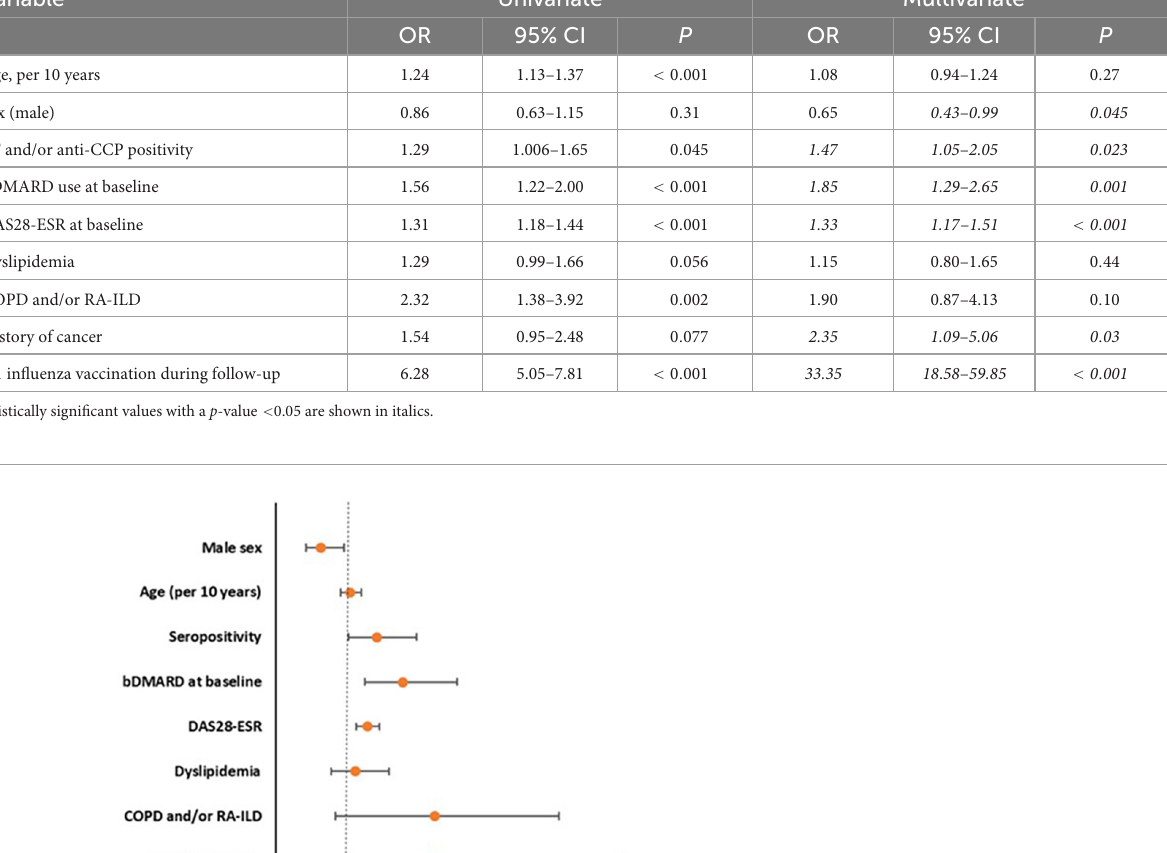
TABLE 4 Uni- and multivariate logistic regression analysis of factors associated with pneumococcal vaccination among non-vaccinated patients ( n = 1,111) during follow-up. Variable Univariate Multivariate